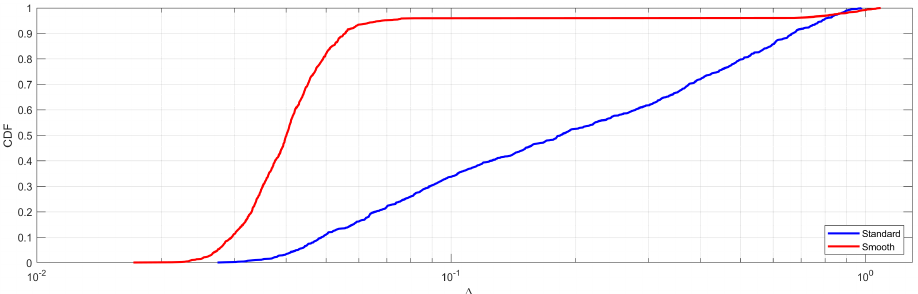
Figure 7. Cumulative density function of the reconstruction error for the random sets of S = 5 sparse sources in the Ξ region for SNR = 40 dB.